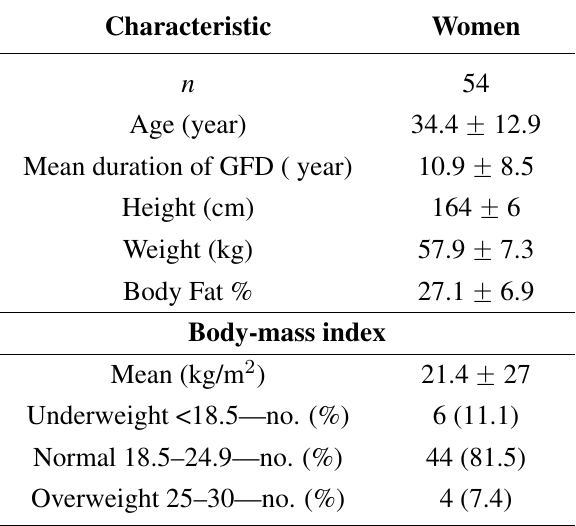
Table 1. Characteristic of celiac participants included in